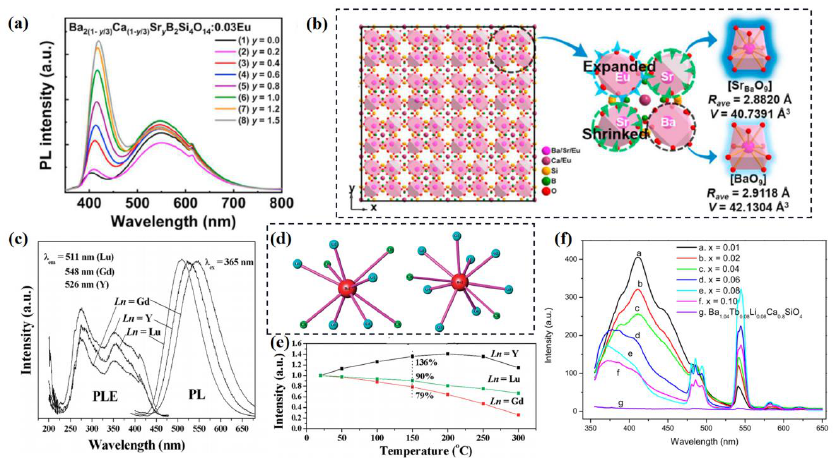
Figure 14. ( a ) PL spectra of Ba 2(1 − y/3) Ca (1 − y/3) Sr y B 2 Si 4 O 14 :Eu (0 ≤ y ≤ 1.5) phosphors (λ ex = 318 nm). ( b ) Schematic diagram of structural evolution after cationic Sr substitution. Reprinted with permission